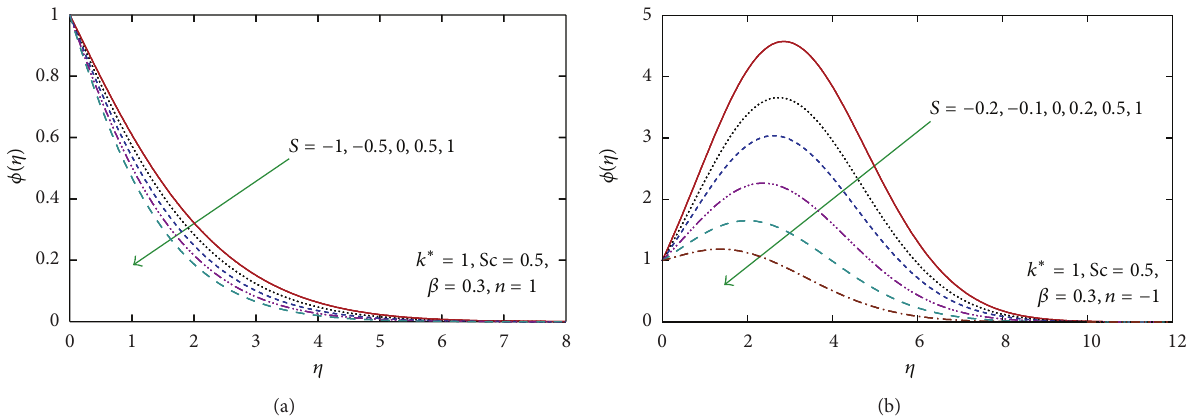
Figure 5: (a) Concentration profiles 𝜙(𝜂) for different values of 𝑆 with 𝑛 > 0 . (b) Concentration profiles 𝜙(𝜂) for different values of 𝑆 with 𝑛 < 0 .